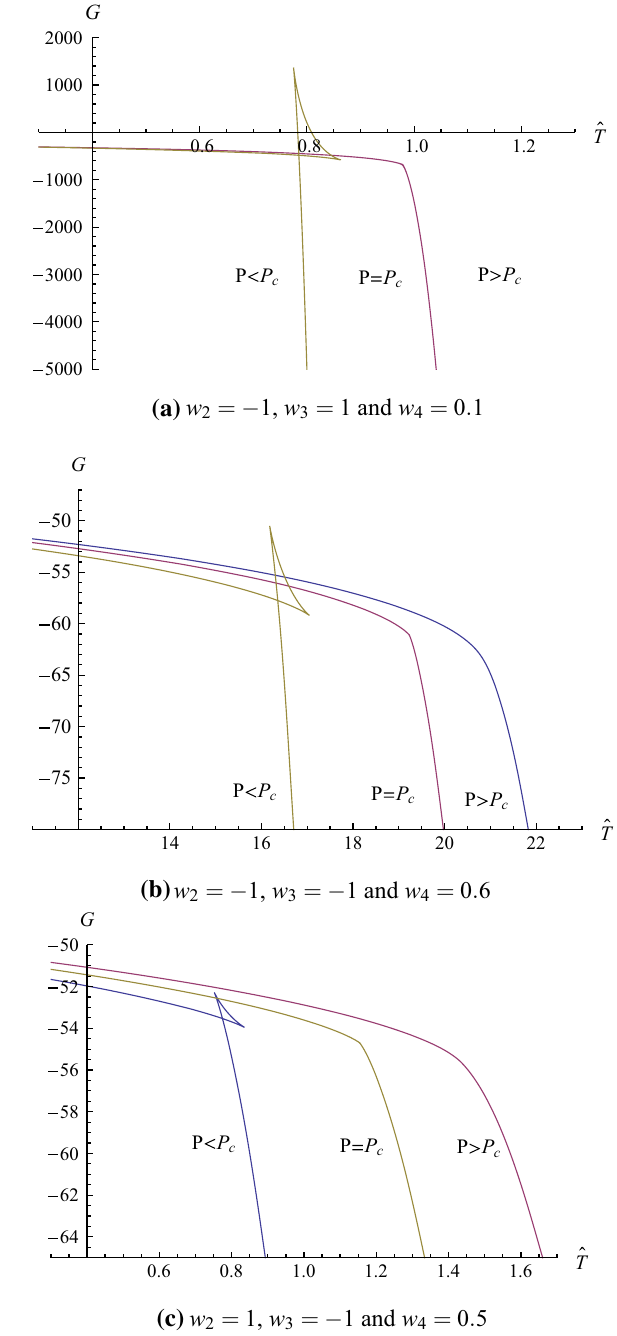
Fig. 5 The G − ˆ T diagrams of six-dimensional AdS black holes. The behavior of the Gibbs free energy is depicted as a function of tempera- ture for fixed pressure. There is one critical point and the corresponding Van der Waals-like phase transition for ˆ T < ˆ T c